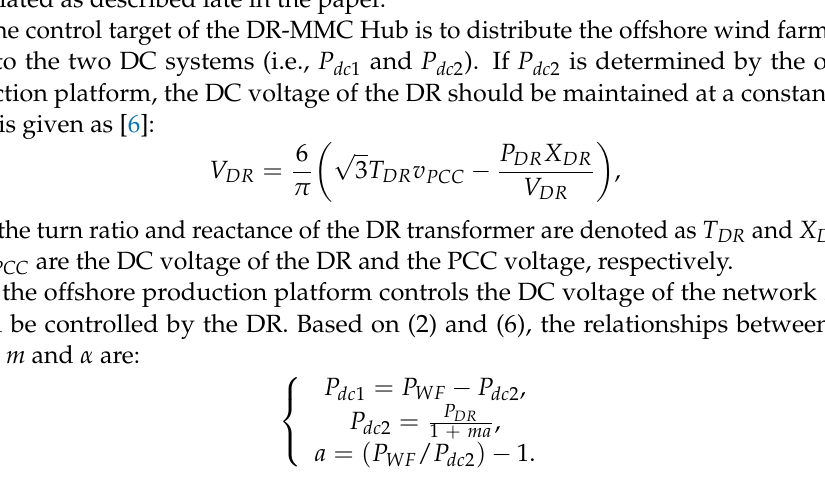
Figure 3. System control diagram of the DR-MMC Hub (The symbols with “*” denote to the reference inputs).